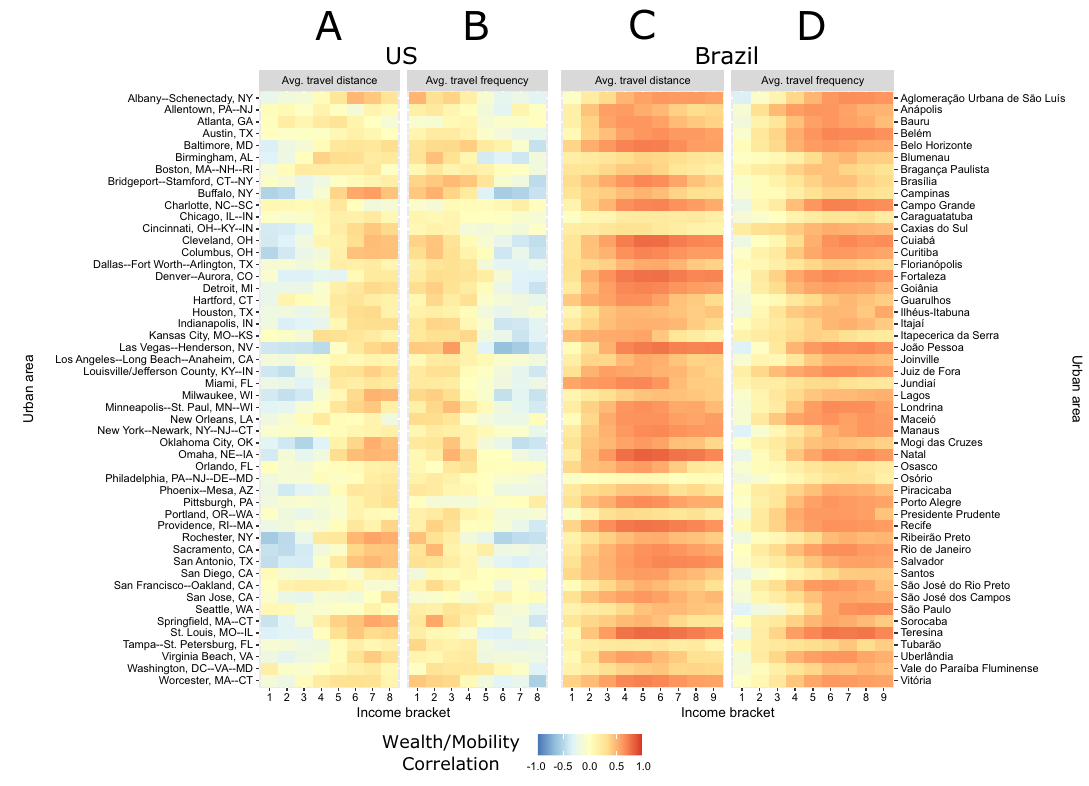
Figure 3. Correlation between income and mobility. For each income bracket (divided into eight buckets), Spearman correlation between the share of residents and the average travel distance, as well as average travel frequency for the United States ( A , B ) and Brazil ( C , D ). The colors indicate the level of correlation from dark- blue (− 1) to dark orange